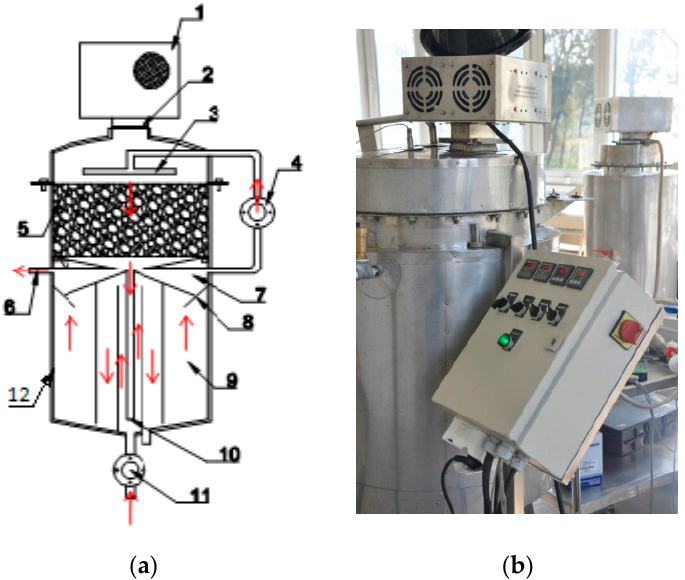
Figure 2. Diagram ( a ) and photograph ( b ) of the M-SHAR (1—microwave generator, 2—microwave generator seal, 3—LDW supply, 4—circulation pump, 5—US of bed, 6—outlet, 7—LS; sludge sepa- ration area, 8—sludge collector, 9—LS; granular sludge area, 10—central hose, 11—LDW metering pump, 12—water jacket used in stage 2).